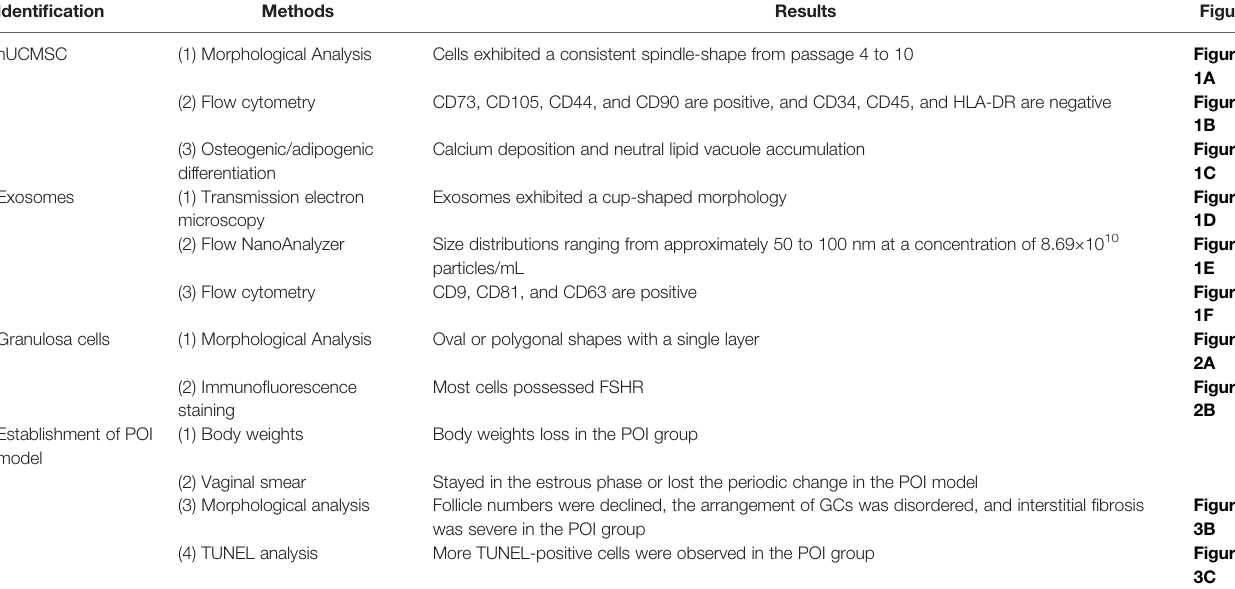
TABLE 1 | Results of identi fi cation of hUCMSCs, hUCMSC-Exos and GCs, and establishment of POI